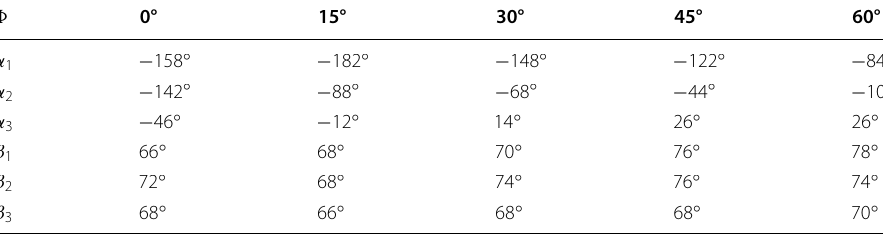
Table 2 Parameters for C UCA,2 maximizing the average correlation in the SCM UMa environment (cid:31)